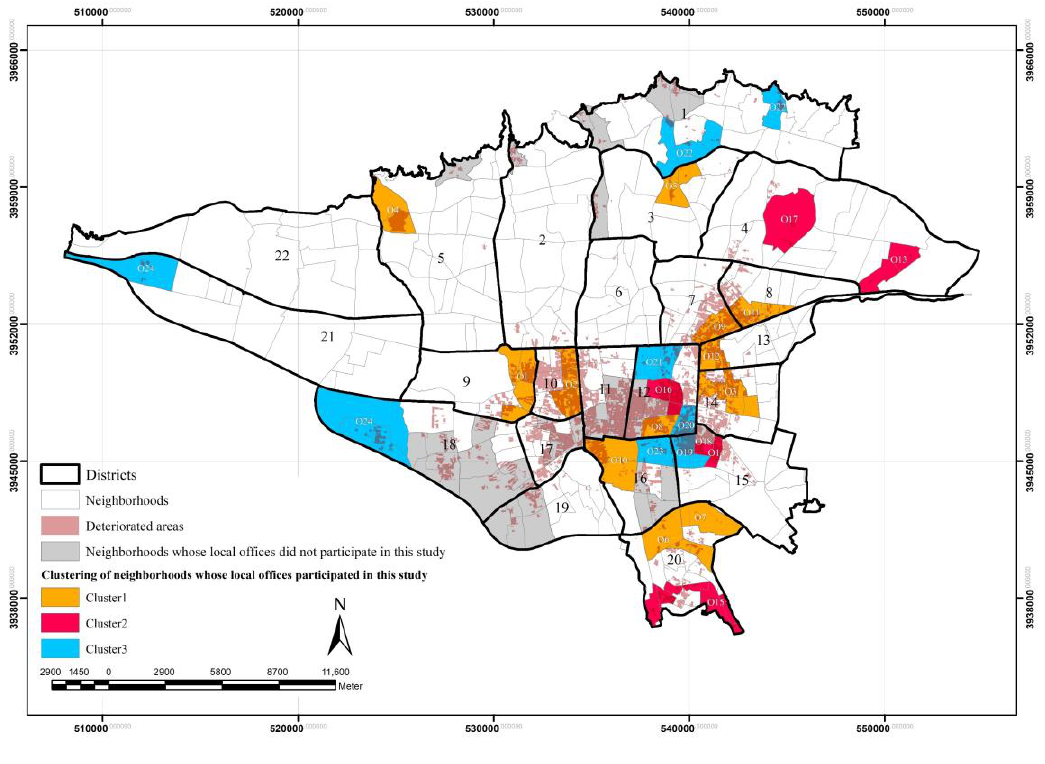
Figure 4. Neighborhoods clustering.